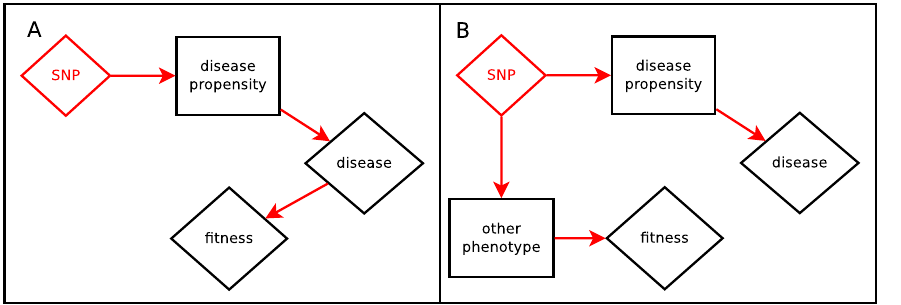
Figure 1. Hypotheses relating SNP effect and fitness effect. Panel A depicts the scenario where the trait is directly under selection. Panel B depicts the scenario where a gene with pleiotropic effects creates fitness-trait correlation via a related